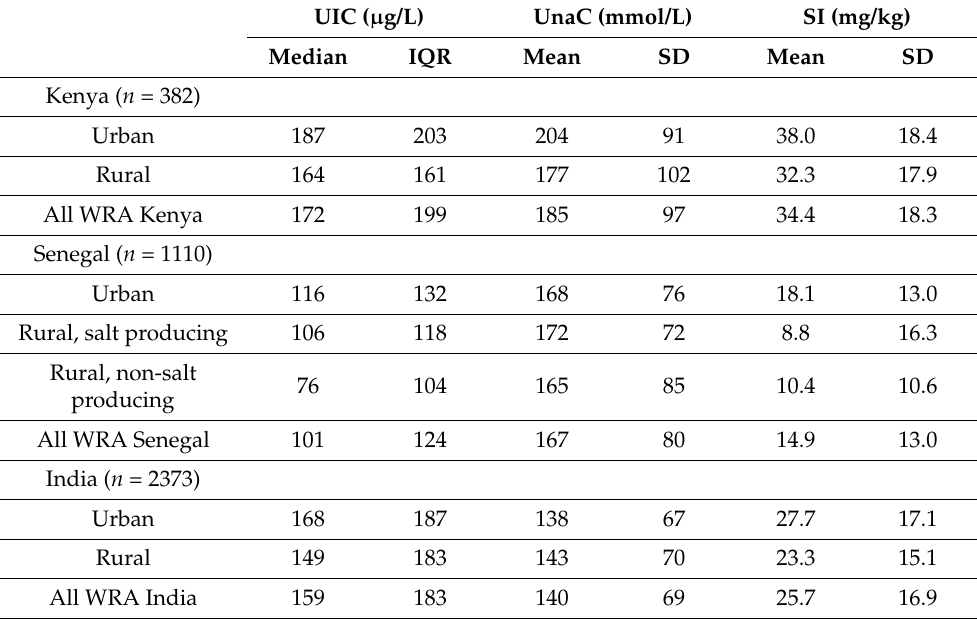
Table 1. Descriptive characteristics of WRA 1 by country and household